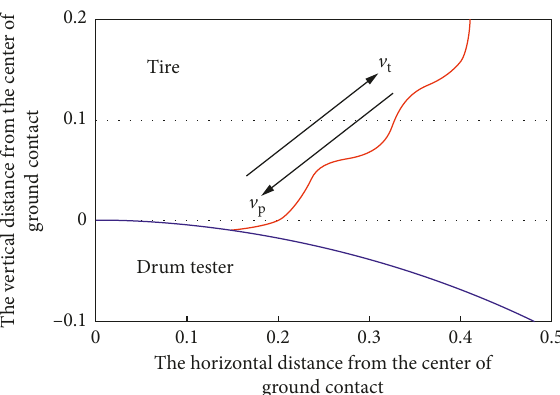
Figure 3: Curve of the tire centerline when v